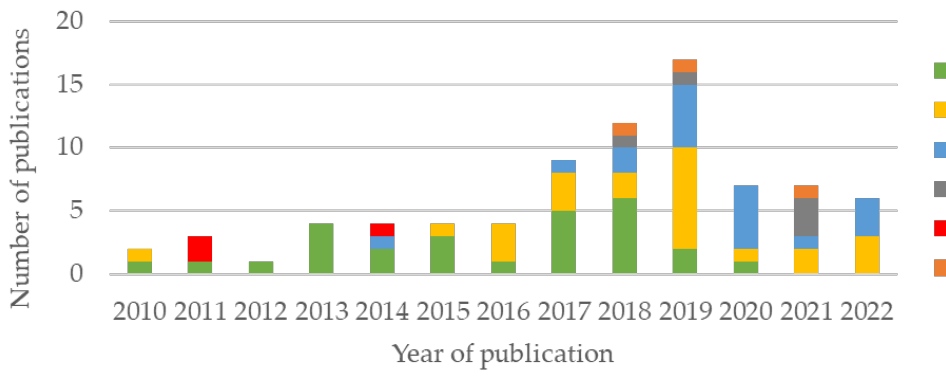
Figure 3. Distribution of works according to year of publication.